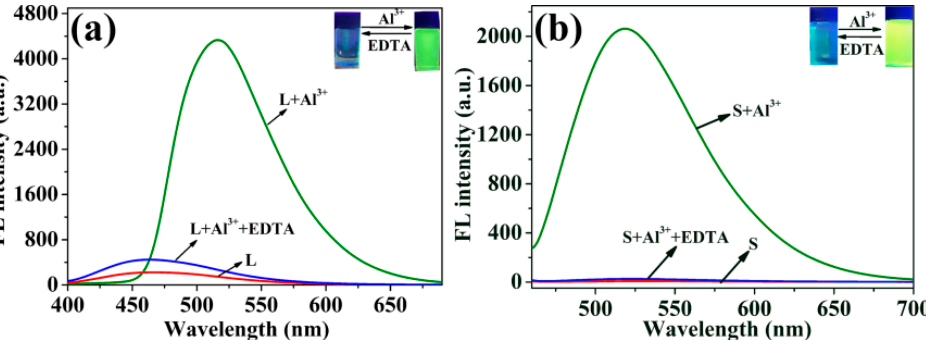
Figure 6. Fluorescent intensity of L ( a ) and S ( b ): L/S, L/S + Al 3+ , and L/S + Al 3+ + EDTA in DMSO/H 2 O ( v : v = 8:2)